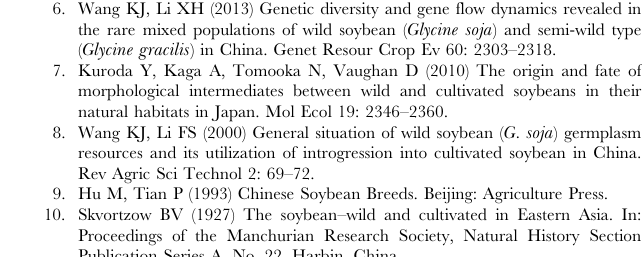
Figure S1 A neighbor-joining phylogenetic tree of wild (blue), semi-wild (red) and cultivated soybeans (green) labelled with seed weight per 100 seeds.